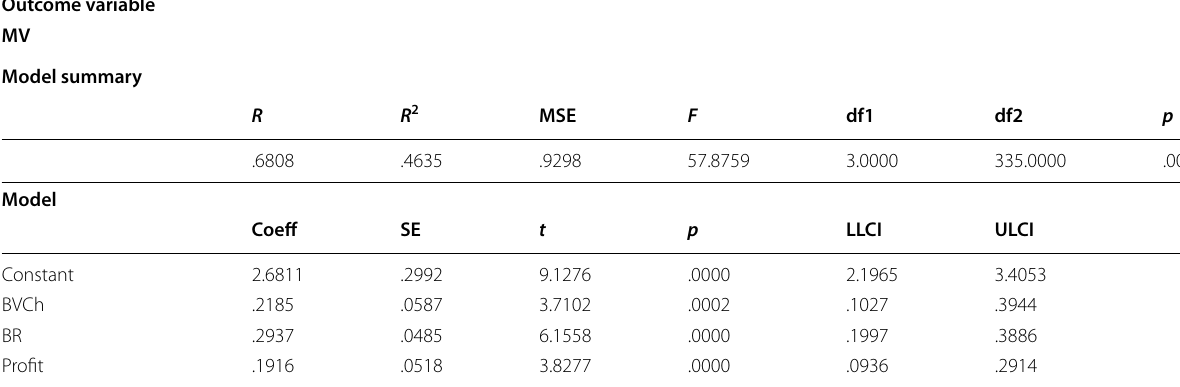
Table 10 The output of market value. Source: Author’s calculations using Hayes Process Macro Model 5 Outcome